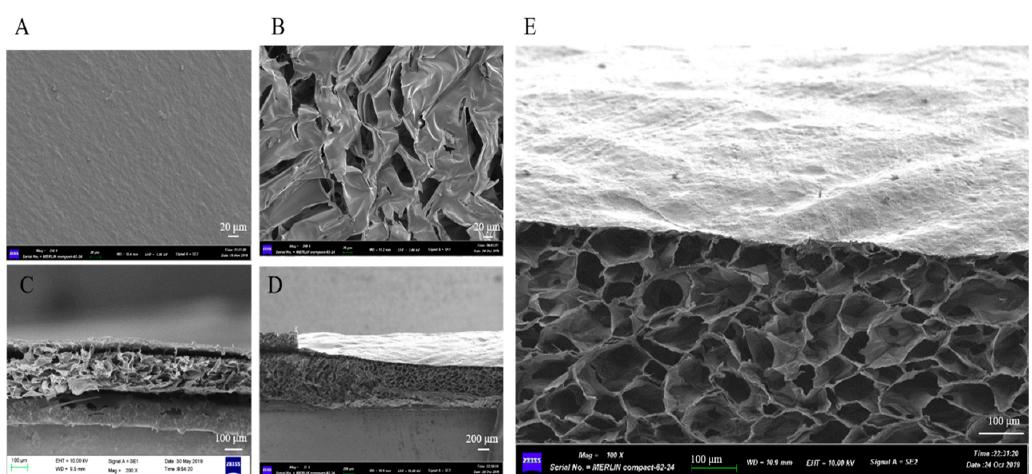
Figure 2. The morphology of double-layer membrane, ( A ) the surface of decellularized bovine amniotic membrane (dBAM), ( B ) the surface of sponge, ( C ) the cross profile of M1-1, ( D ) the cross profile of M1-3, ( E ) the enlarged profile of M1-3.